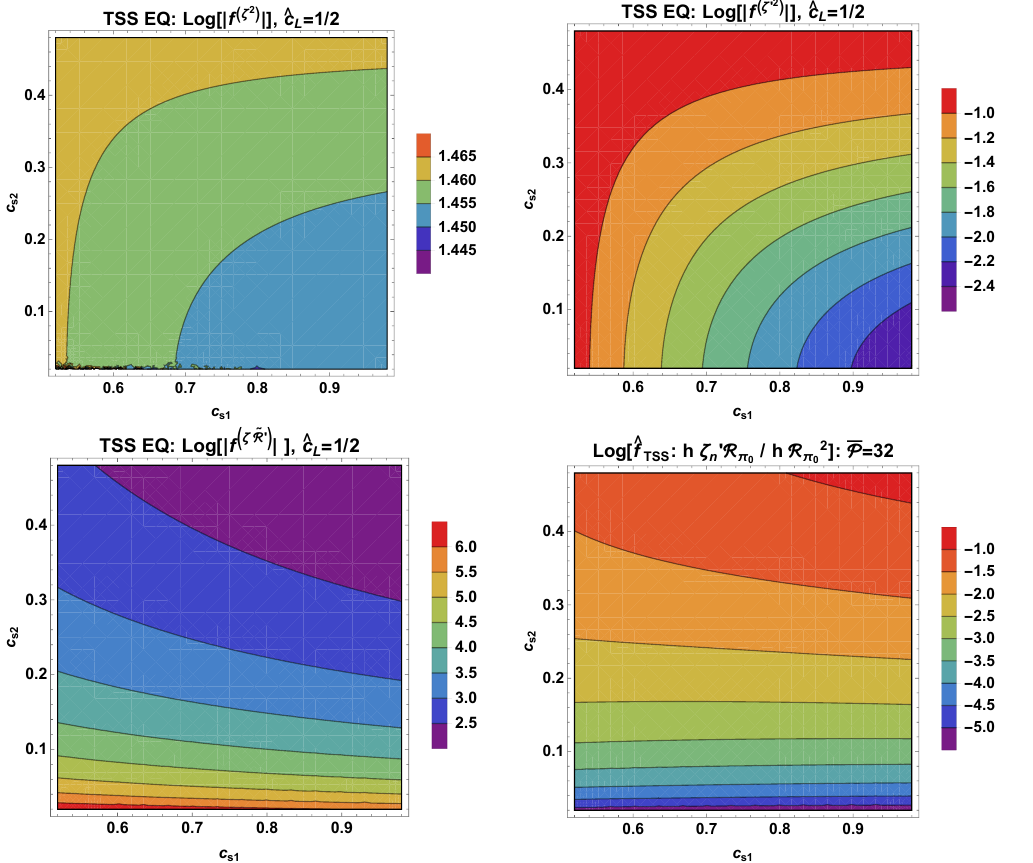
Figure 13 . Equilateral TSS plots. We set V-B constants to one and k t = 10 − 5 .